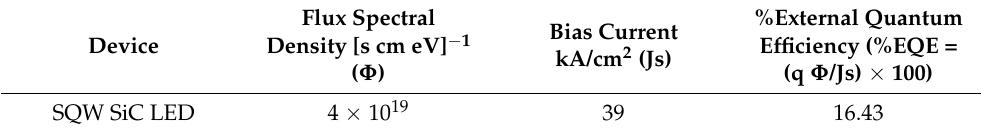
Table 3. External quantum efficiency calculation for simulated LED at 6